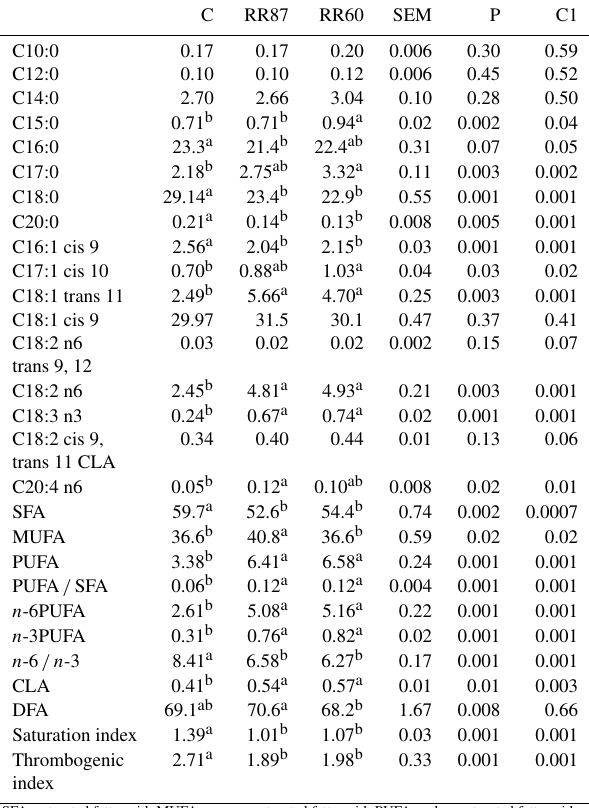
Table 4. Fatty acid profiles as % FAMEs (mg FAME per 100mg FAMEs) of caudal fat (CF) from Barbarine lambs fed distilled rose- mary residues.